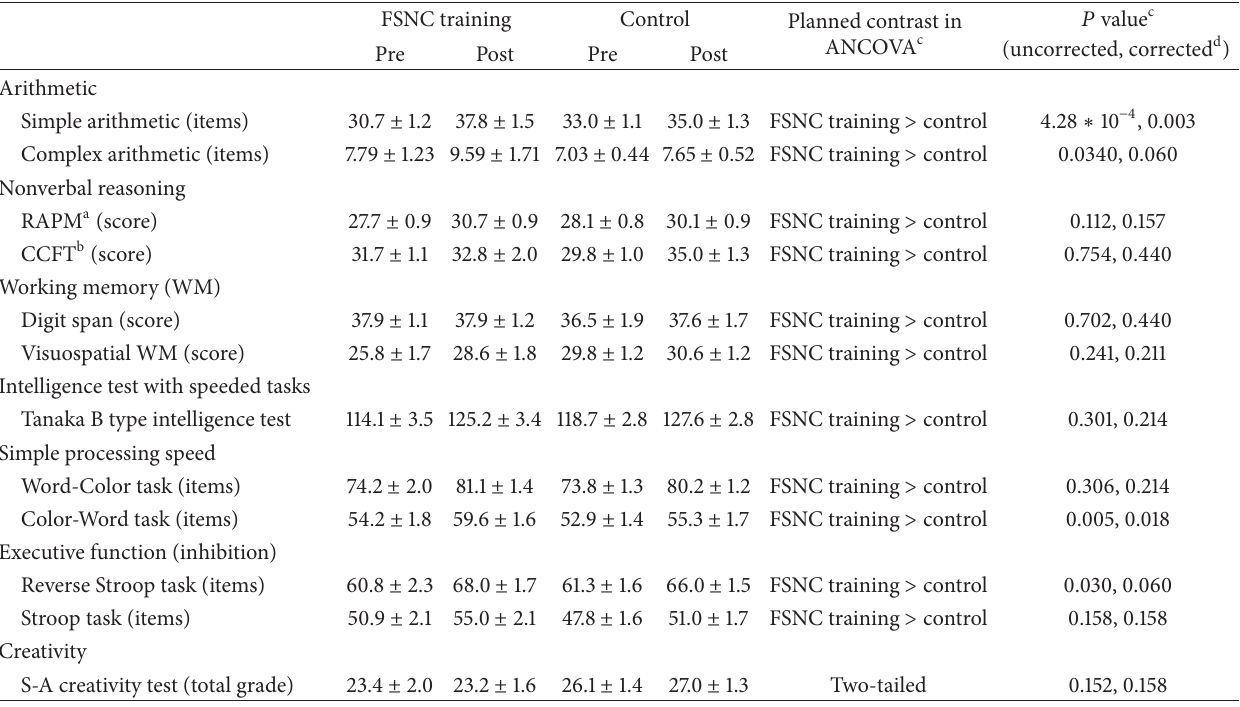
Table 1: Pre- and posttest scores for psychological measures (mean ±